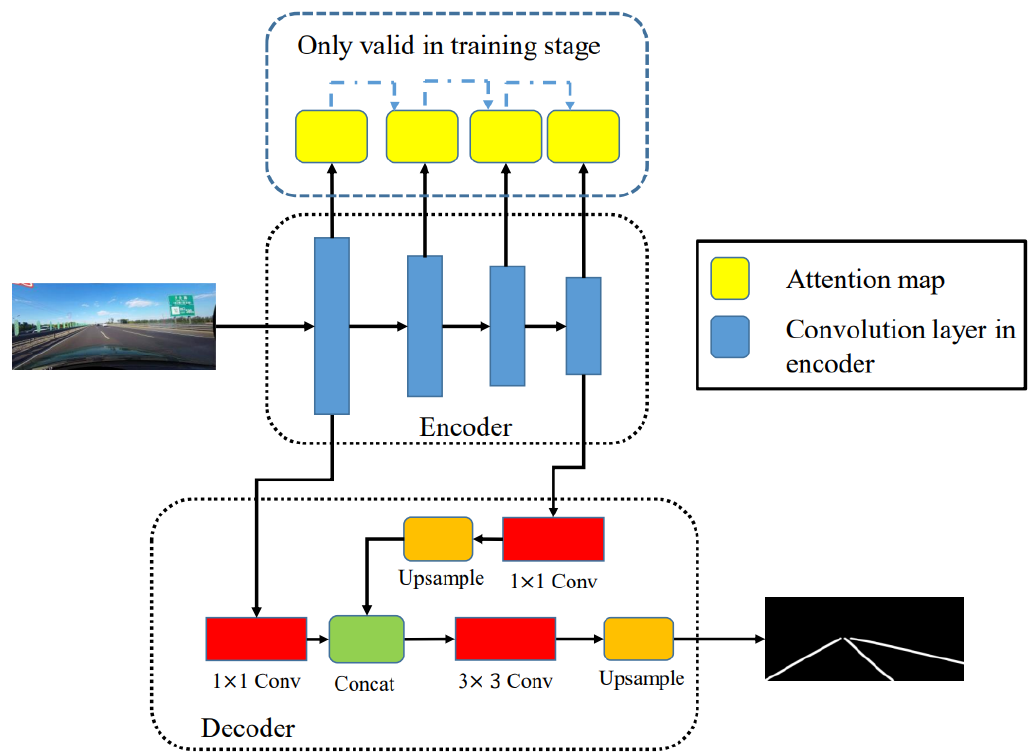
Figure 2. The overall architecture of the proposed method.